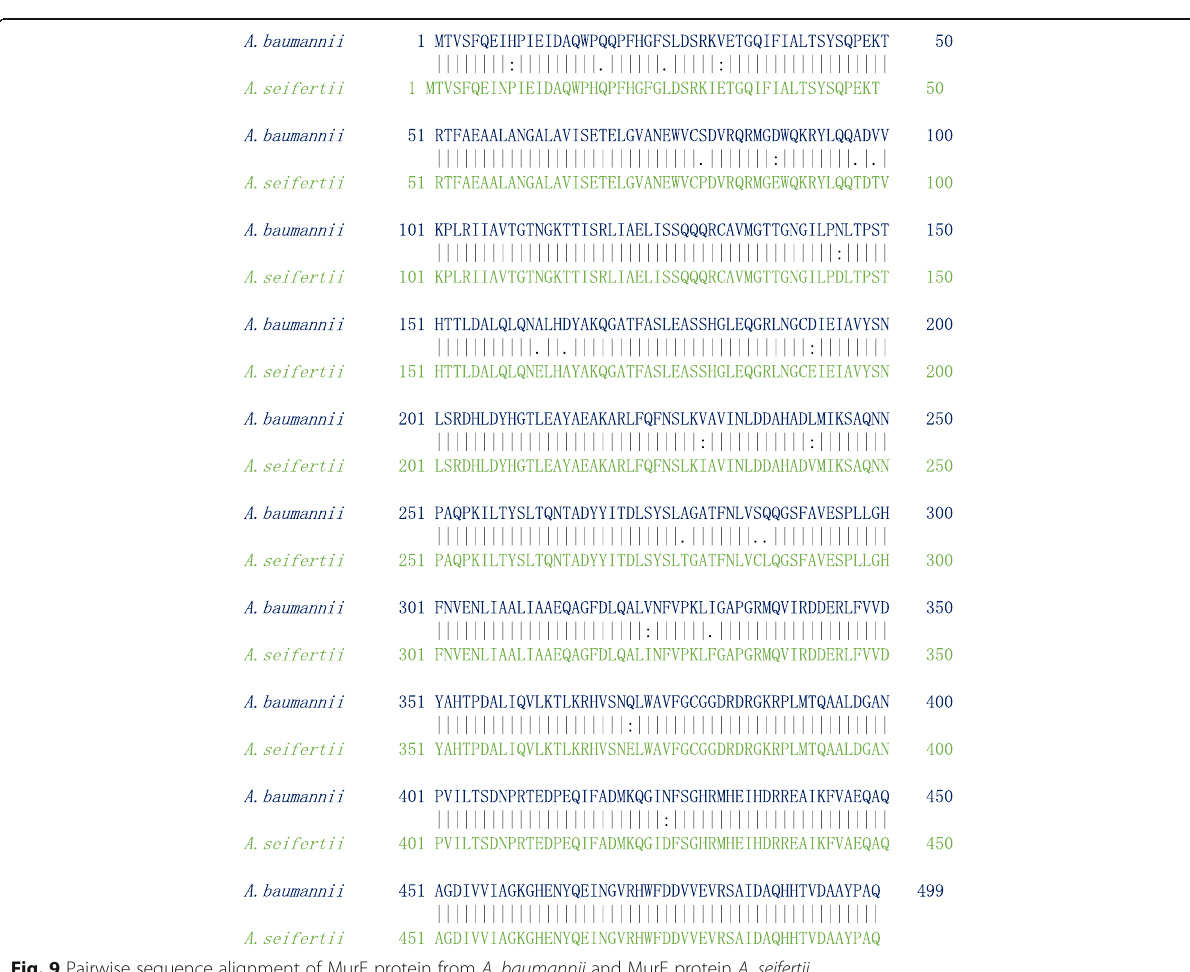
Fig. 9 Pairwise sequence alignment of MurE protein from A . baumannii and MurE protein A . seifertii